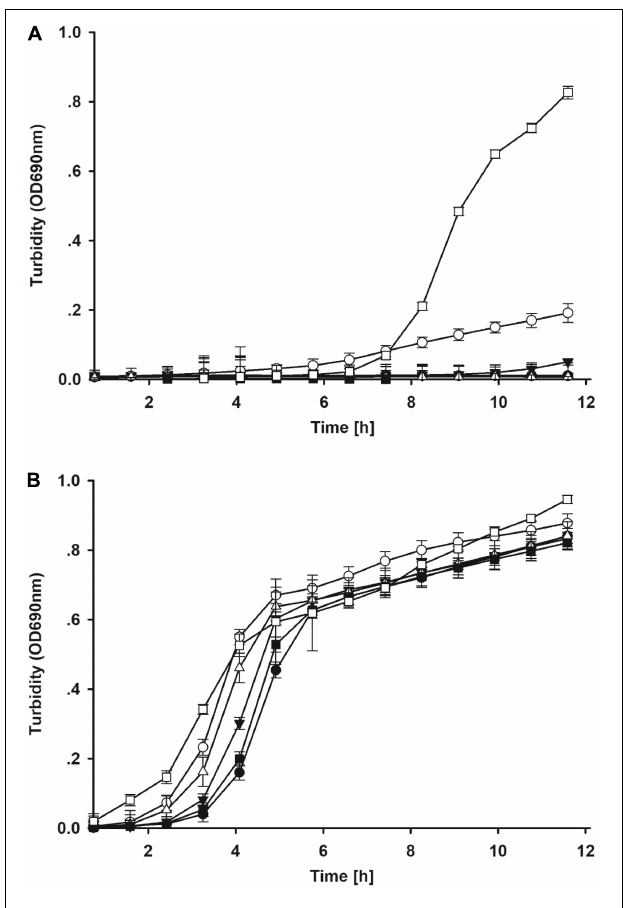
FIGURE 3 | (A) Growth of the model E. coli strain after ex vivo co-incubation with candidate lactic acid bacteria isolates for 8 h in crop contents. Filled circle = S1; open circle = S26; filled down triangle = S62; open downward triangle open diamond = S70; filled square = S73; open square = control. (B) Growth of the model E. coli strain after ex vivo co-incubation with candidate lactic acid bacteria isolates for 8 h in jejunum contents. Filled circle = S1; open circle = S26; filled down triangle = S62; open downward triangle open diamond = S70; filled square = S73; open square = control.